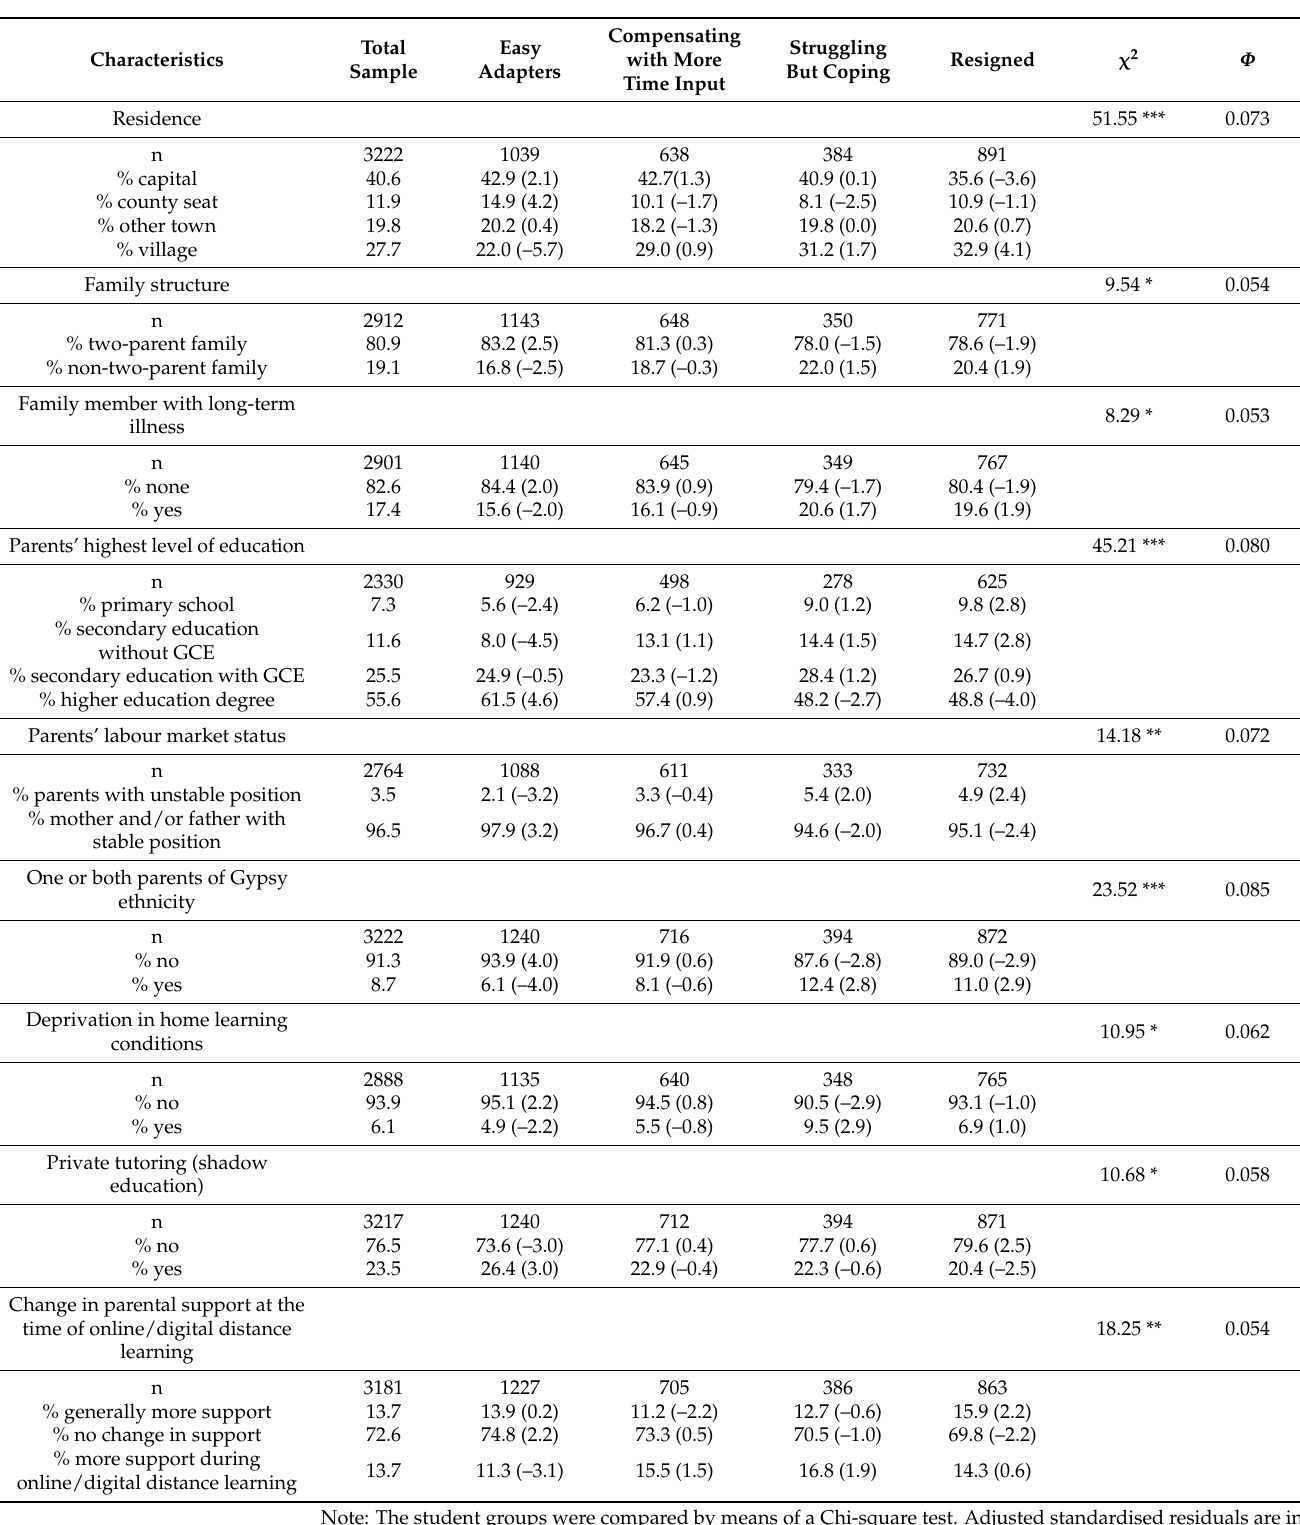
Table 3. Distributions by family background characteristics in learner groups having different perceptions of online/digital distance